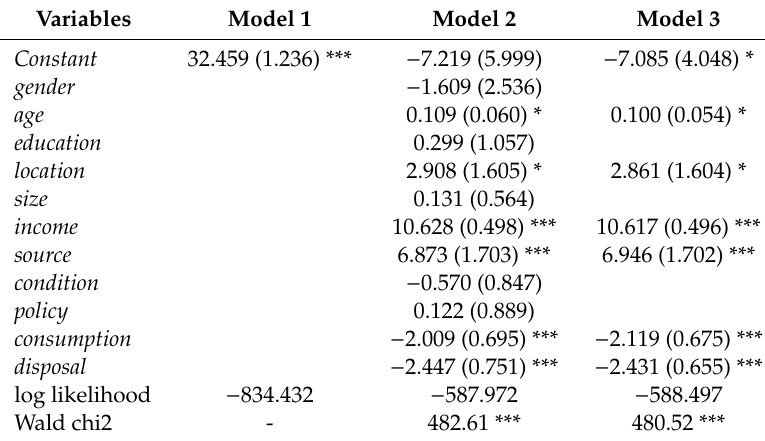
Table 2. Estimation results of the double-bounded